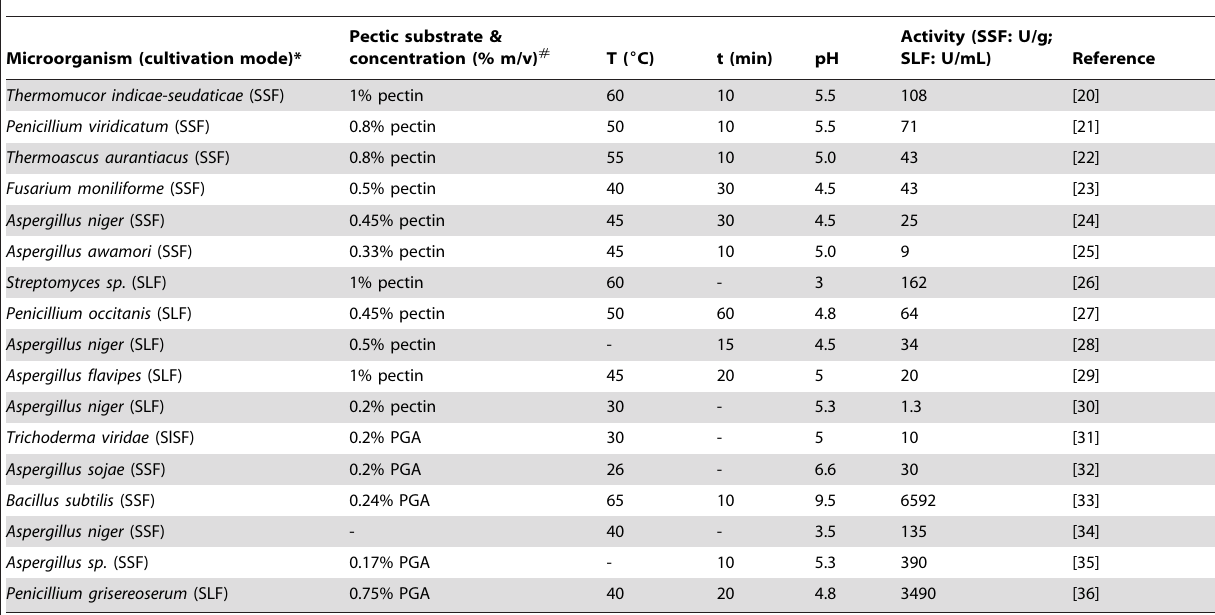
Table 2. Hydrolysis conditions used in assays for pectinase activities reported in the literature.